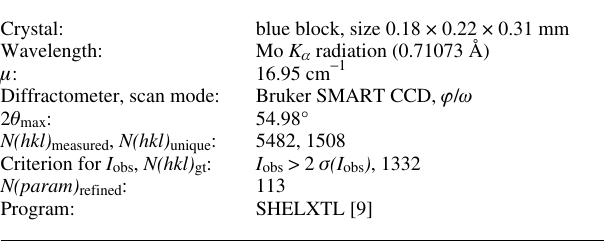
Table 1. Data collection and handling.